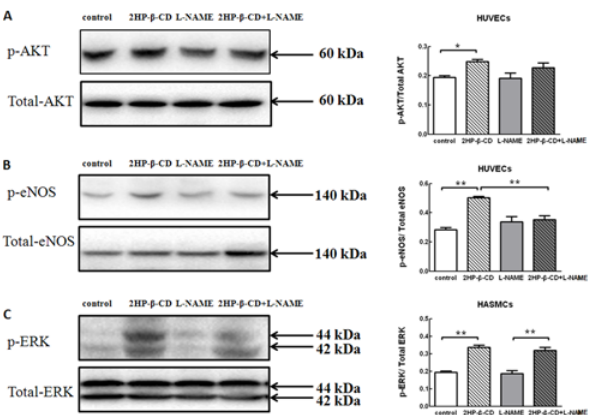
doi:10.1371/journal.pone.0125323.g002